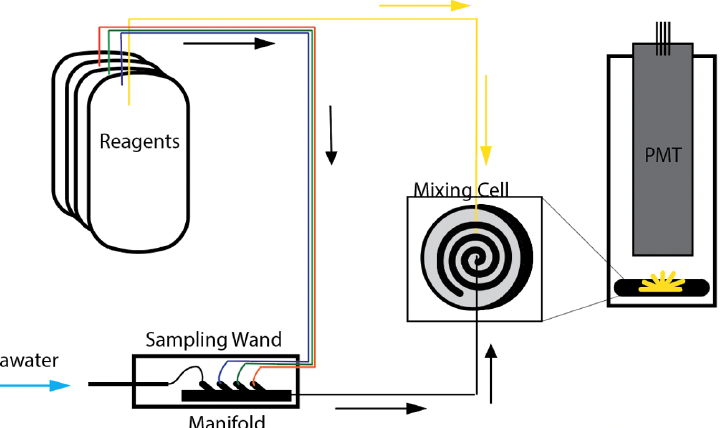
Figure 2. An overview of the pump-driven mixing of fluids in the SOLARIS. Reagents within the reagent assembly, with the exception of MCLA (shown in the yellow line) are directed, and mix with seawater in a manifold in the sampling wand. This flow is then directed to a spiral flow cell where it mixes with MCLA, and is monitored by a photomultiplier